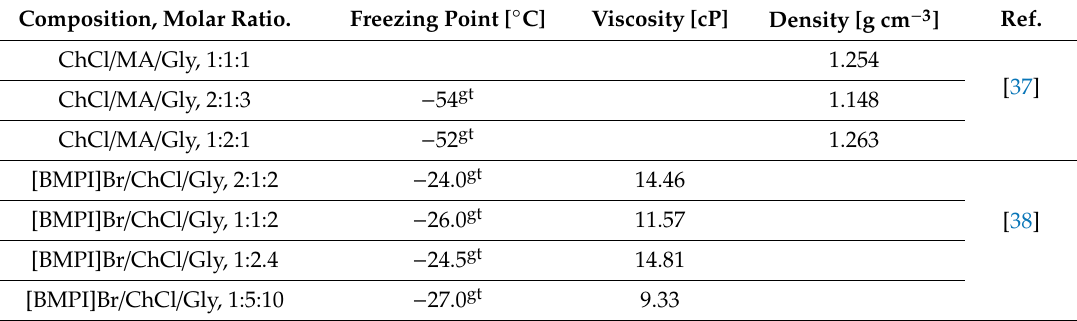
Table 3. Composition and physical properties of selected ternary Class III DESs at 298 K (AA = acetamide; [BMIM]Cl = 1-Butyl-3-methyl imidazolium chloride; U = urea; ChCl = choline chloride; Gly =